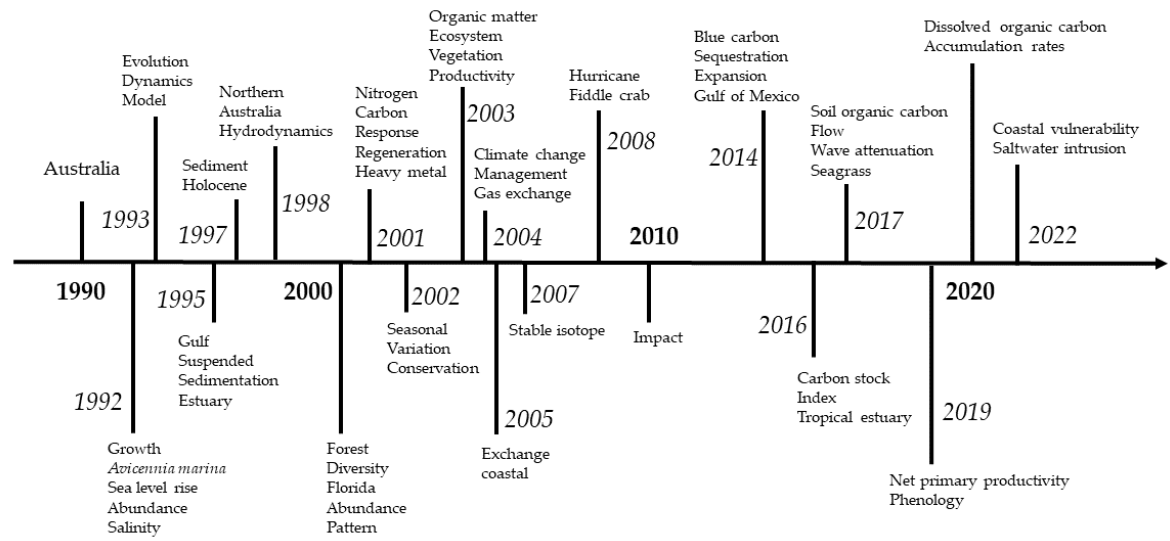
Figure 13. Evolution of research topics in mangrove-climate change studies from 1977 to 2021.